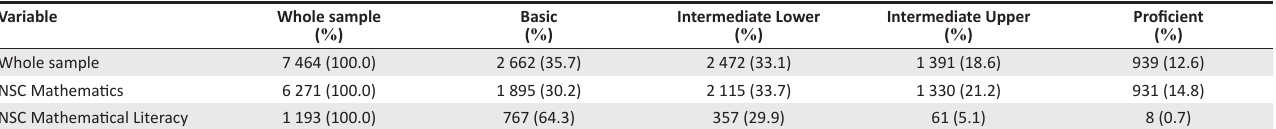
TABLE 7: Numbers and percentage distribution across quantitative literacy performance categories for the total sample and of subsets defined by National Senior Certificate mathematics subject written. Variable